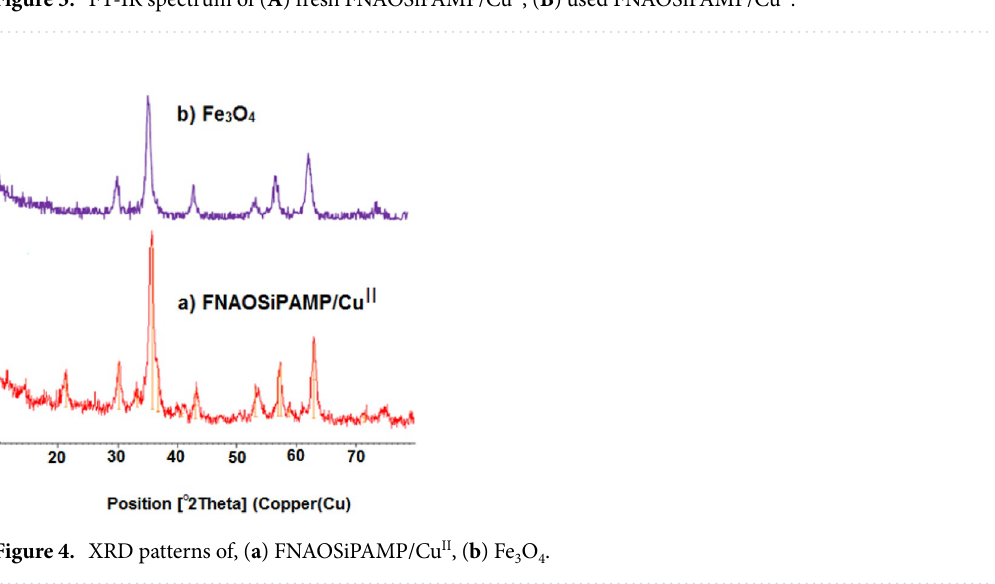
Figure 3. FT-IR spectrum of ( A ) fresh FNAOSiPAMP/Cu II , ( B ) used FNAOSiPAMP/Cu II .